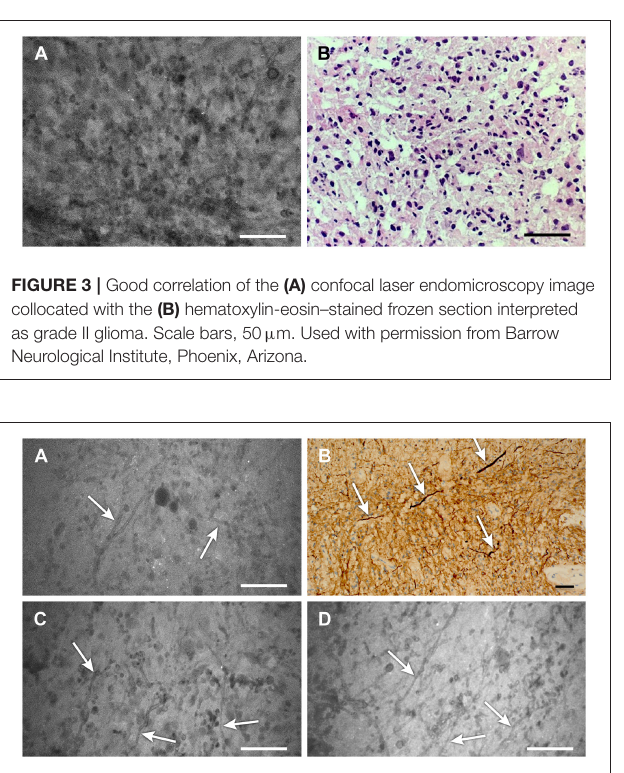
FIGURE 4 | (A–D) Confocal laser endomicroscopy (CLE) images showing areas of low-grade glioma (A,C,D ) that reveal distinct strand-like structures or fibers throughout the tumor (scale 50 µ m). (B) Image from the same area stained for neurofilaments ( arrows ) also shows these structures, which are likely swollen axons resulting from tumor edema (scale bar, 20 µ m). We have not previously observed these detailed structures on CLE images with low-dose fluorescein sodium (FNa) staining. Their notable appearance here is likely related to the high dose of FNa used in this case. Used with permission from Barrow Neurological Institute, Phoenix,